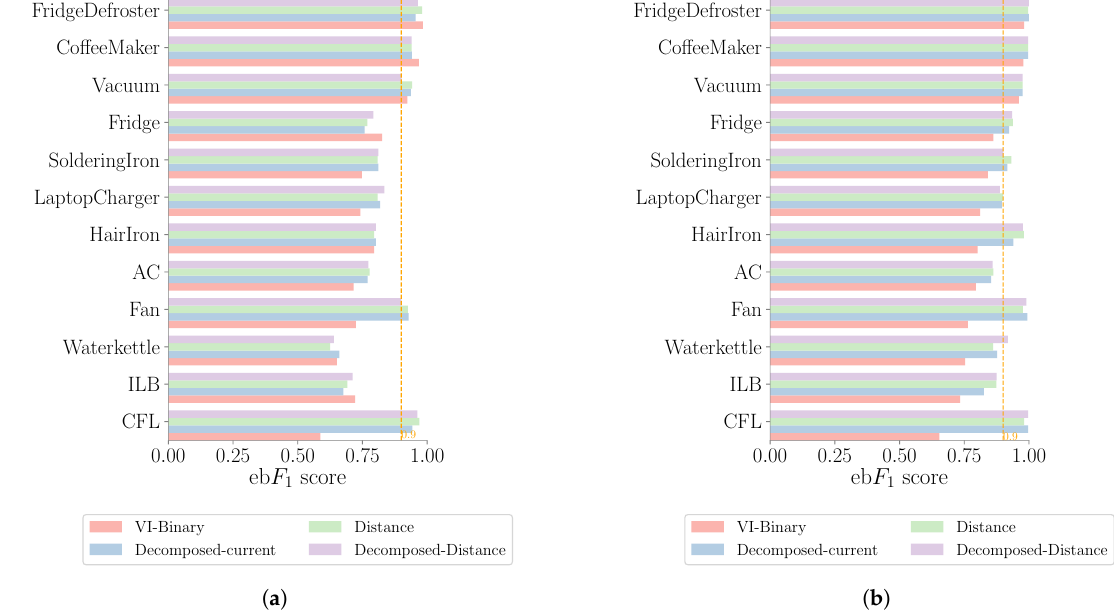
Figure 10. Per-appliance eb F 1 score on PLAID dataset. AC = air conditioning, CFL = compact fluorescent lamp, ILB = incandescent light bulb. ( a ) Multi-label k-nearest-neighbor (MLkNN) ( b ) CNN.